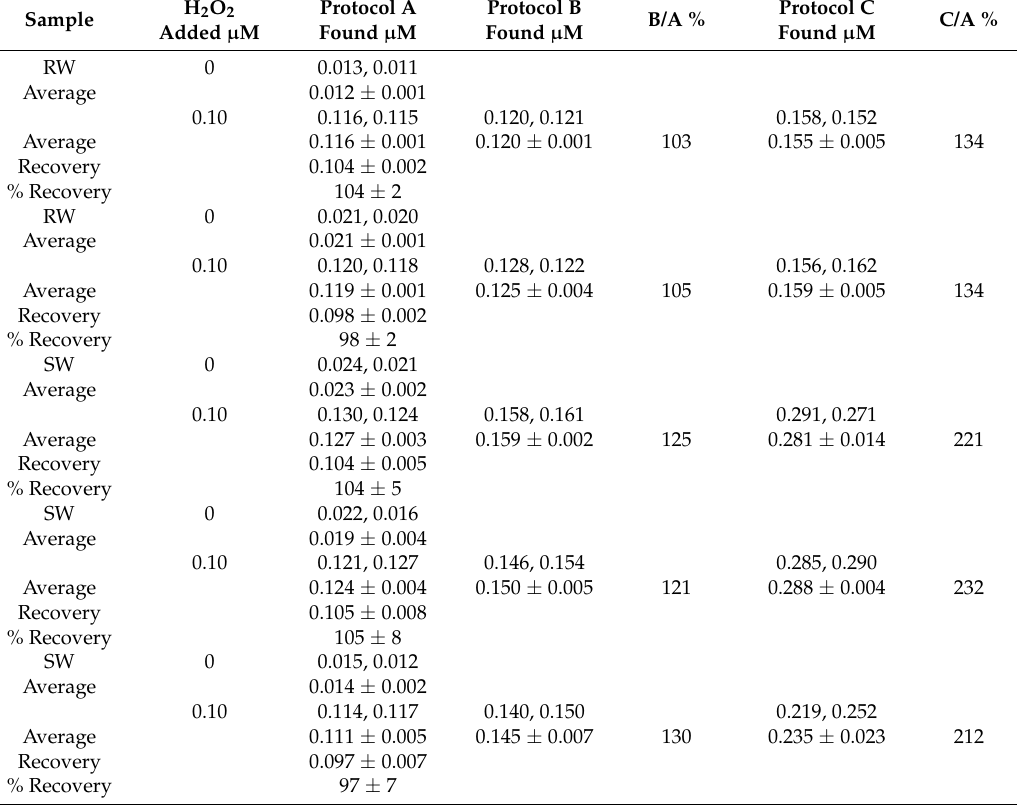
Table 3. Determination of H 2 O 2 in reagent grade water and seawater by three